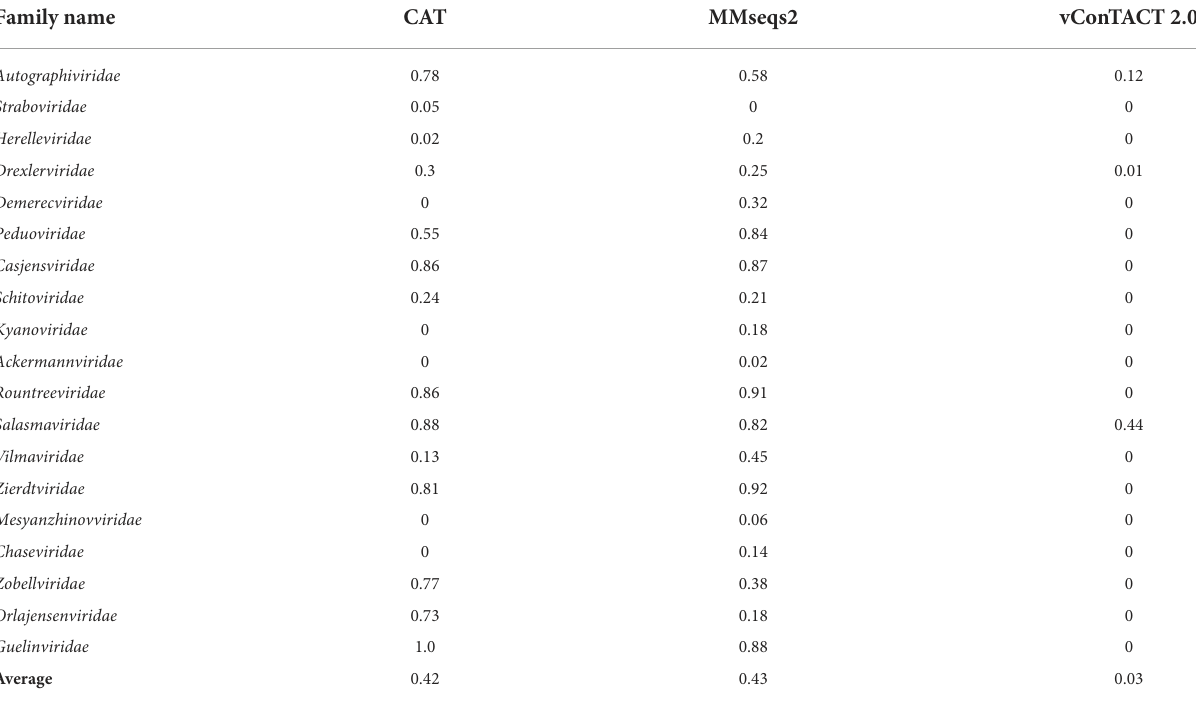
TABLE 4 The percentage of misclassified sequences in leave-one-family-out experiment for each